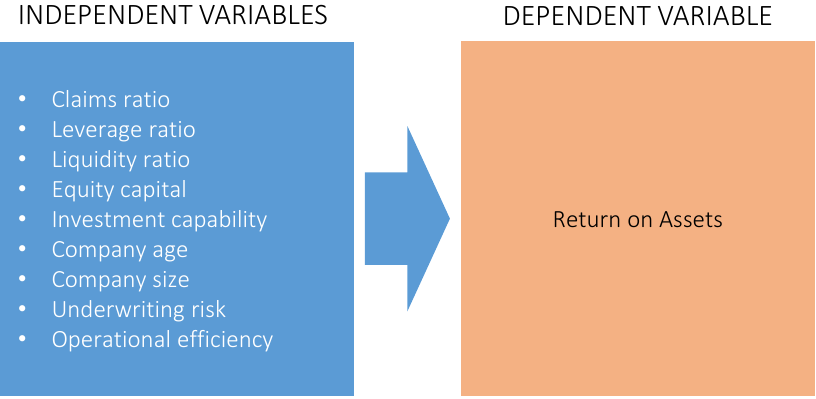
Figure 1. Conceptual